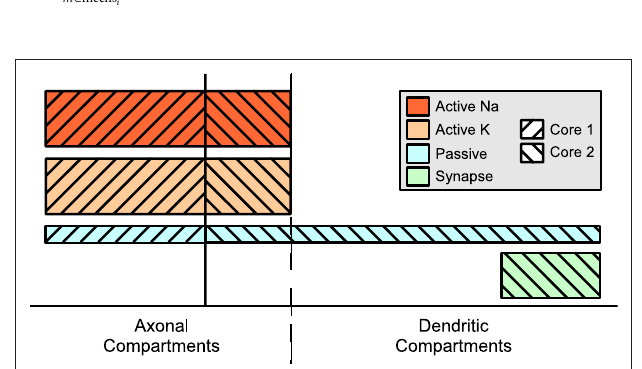
FIGURE 7 | Compartment level parallelization. Solid line separates the two sets of compartments assigned to different cores. This boundary is chosen such that the overall complexity per core is very close to the